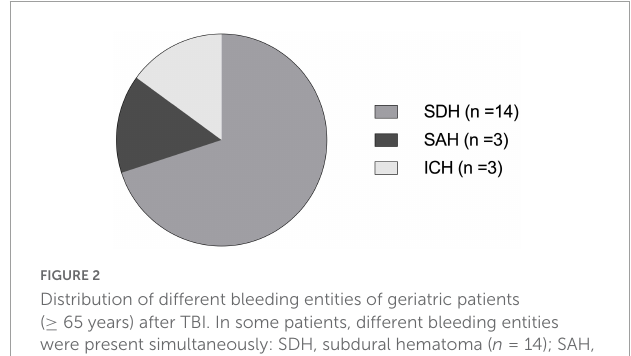
FIGURE2 Distribution of different bleeding entities of geriatric patients ( ≥ 65 years) after TBI. In some patients, different bleeding entities were present simultaneously: SDH, subdural hematoma ( n = 14); SAH, subarachnoid hemorrhage ( n = 3); ICH, intracerebral hemorrhage ( n =